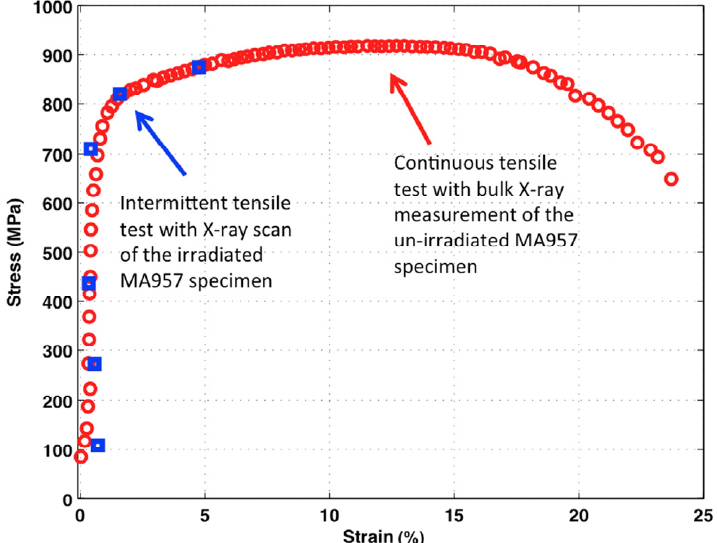
Figure 6. Engineering stress ‐ strain diagram of MA957: the blue squares show stress and strain values during the intermittent tensile test for the irradiated MA957 specimen; the red circles show stress and strain values during the continuous tensile test for the un ‐ irradiated MA957 specimen.